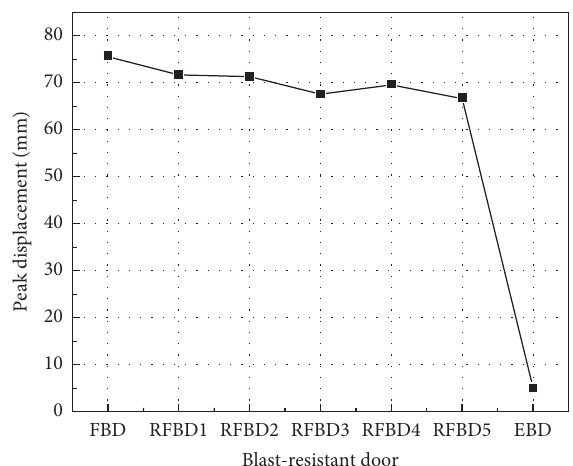
Figure 9: Peak displacement of different blast-resistant